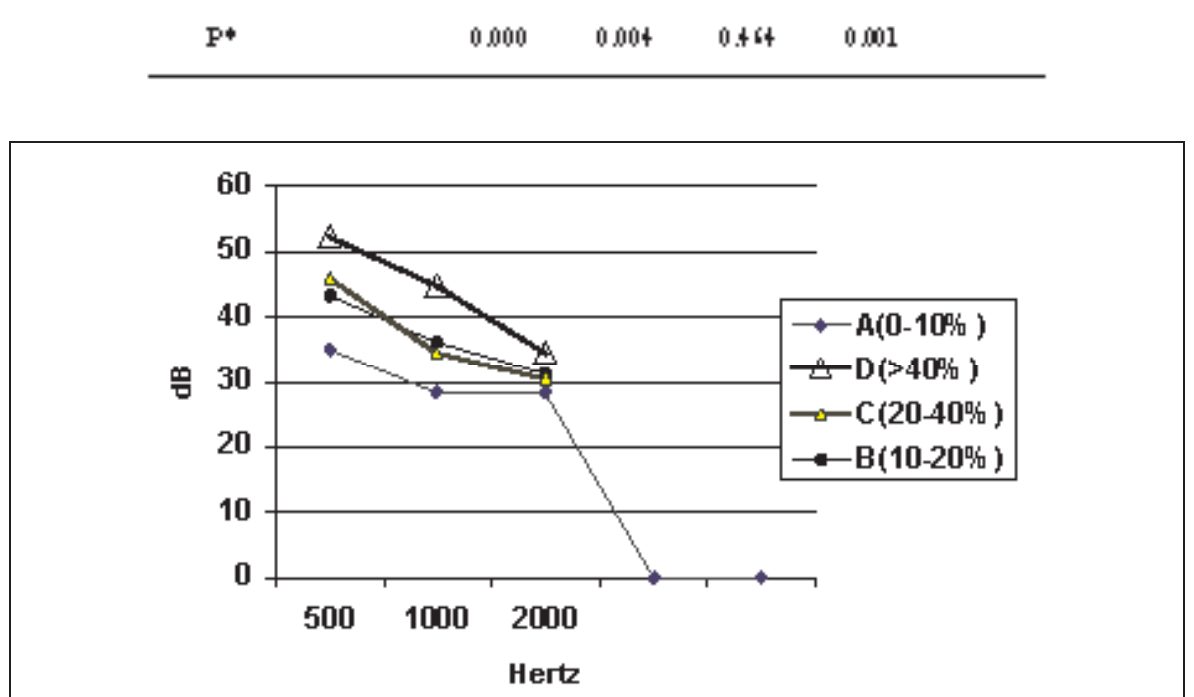
Figure 1 : Size of Perforation and Hearing Loss